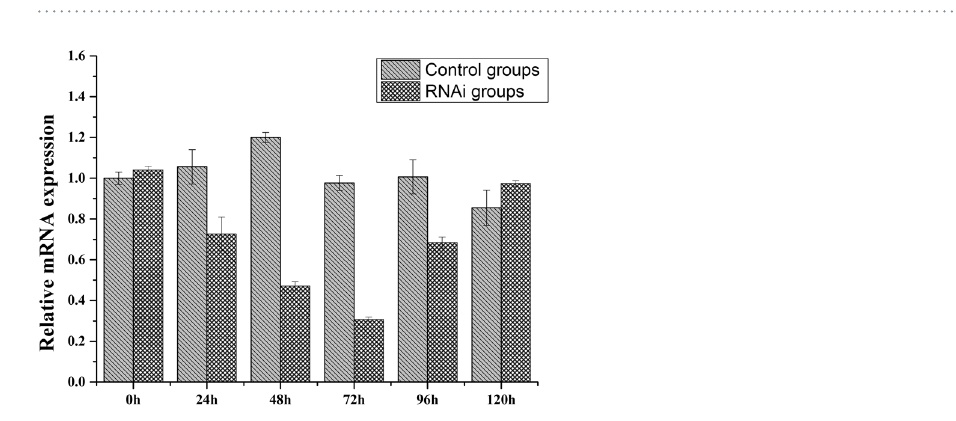
Figure 4. Quantitative real-time PCR analysis of the CgCSAD1and CgCSAD2 gene expression in various tissues. Elongation factor 1 α (EF) gene expression was used as internal control. The y-axis represent the fold changes between the CgCSAD1 and CgCSAD2 expressions of tissues and the CgCSAD2 expression of gill. Vertical bars represent the mean ± SD (n = 6), CSAD: Cysteine sulfinate decarboxylase, Man: mantle, Amu: adductor muscle, Gon: gonad, Dgl: digestive gland, Lpa: labial palp, Hem: hemolymph, Gil: gill.